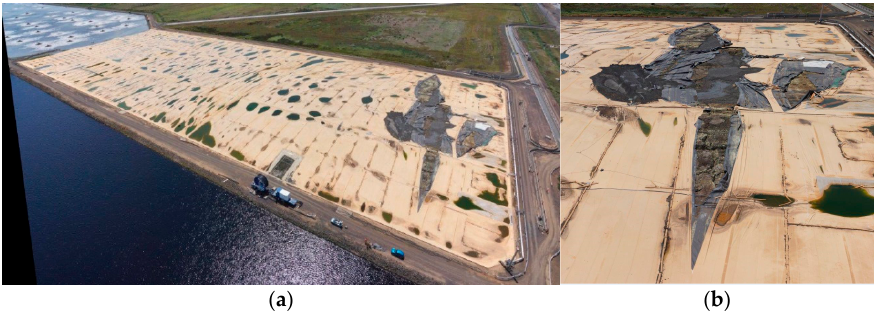
Figure 2. ( a ) Photograph of a failed floating cover, following an unexpected failure in December 2014, exposing the underlying scum-berg; and ( b ) close-up view of the torn cover exposing the underlying scum-berg.